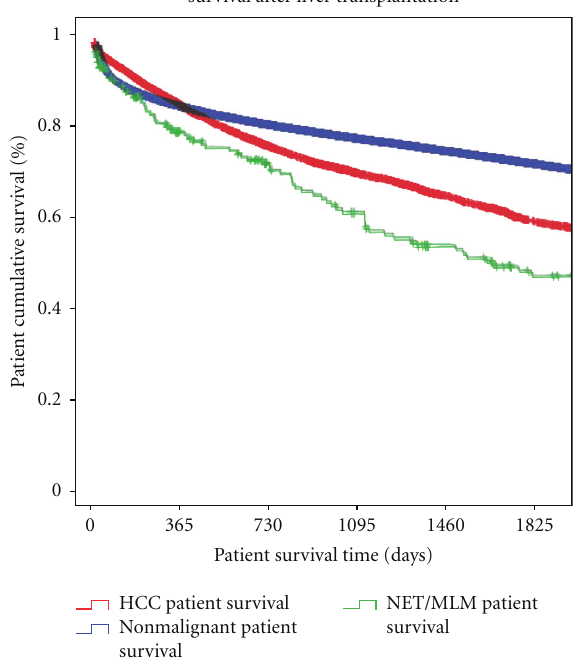
better than patients transplanted for NET/NLM ( P = 0 .